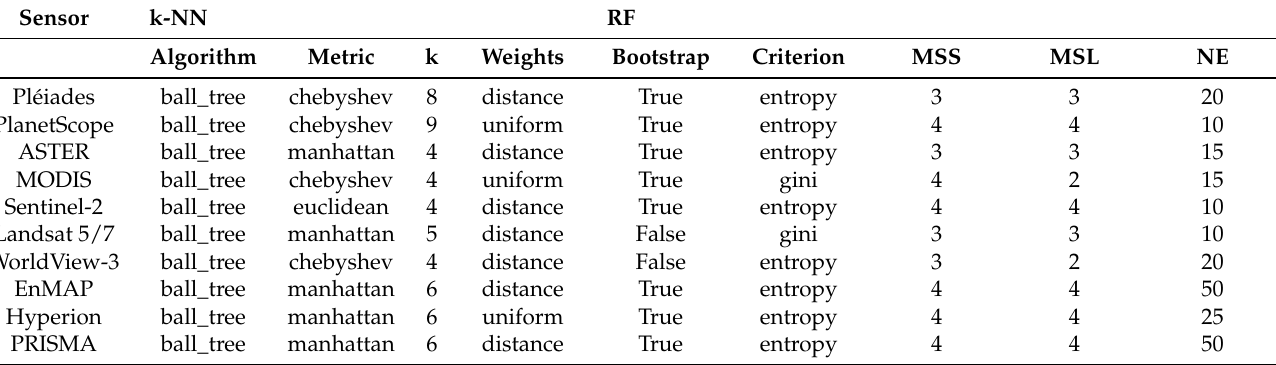
Table A2. Model parameter values as derived from parameter tuning. For k-NN, k is the number of neighbors. For RF, MSS is the minimum number of samples required to split an internal node, MSL is the minimum number of samples required to be at a leaf node, and NE is the number of estimators. Sensor RF